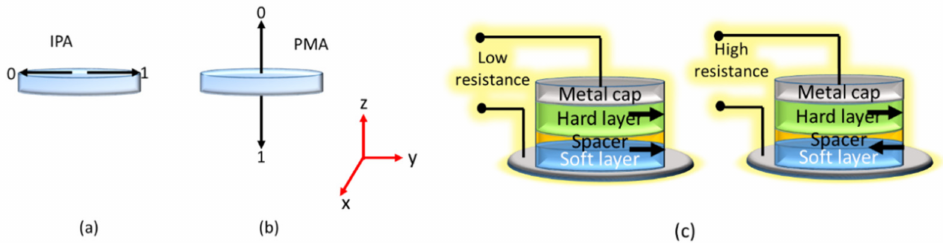
Figure 2. A nanomagnet shaped like an elliptical disk has two stable magnetization orientations which can encode the binary bits 0 and 1. ( a ) In-plane magnetic anisotropy and ( b ) perpendicular magnetic anisotropy. ( c ) A magnetic tunnel junction (MTJ) showing the high (OFF) and low (ON) resistance